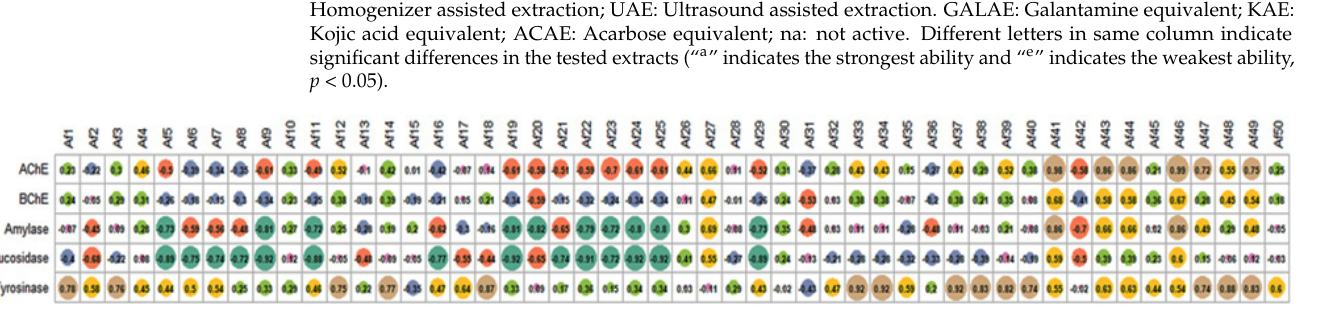
Figure 4. Relationship between secondary metabolites and enzyme inhibitory activities of Alcea fasciculiflora. For compounds numbers refer to Table 1. The correlation is considered positive and statistically significant (r > 0.7).